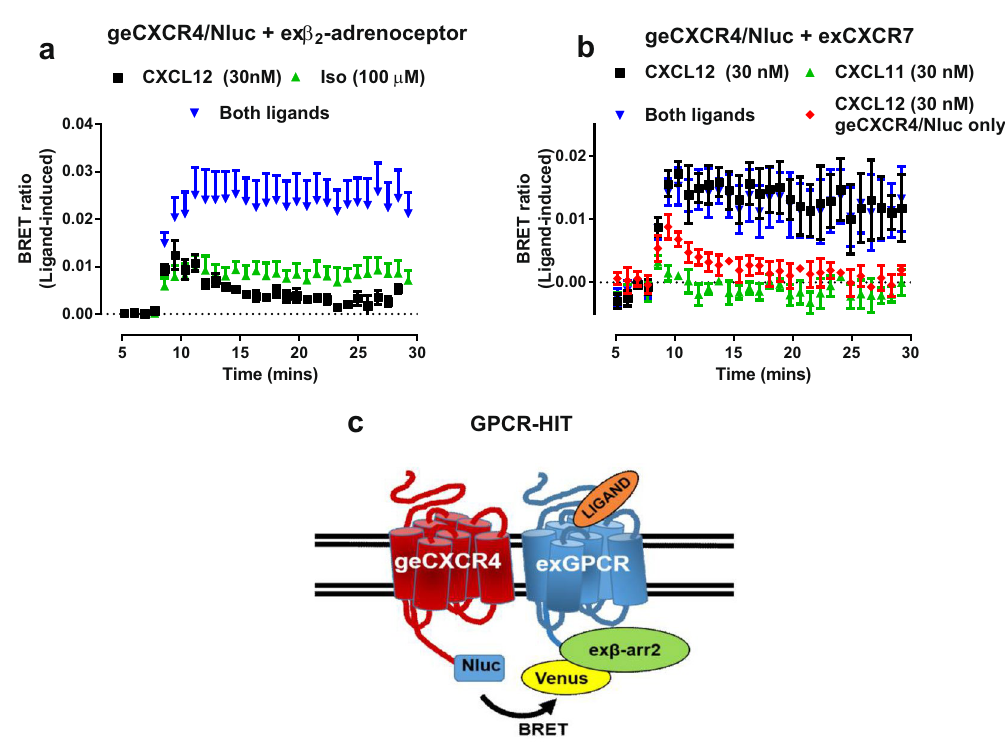
Figure 5. Demonstration of GPCR-HIT BRET assay using genome-edited CXCR4. HEK293FT cells expressing genome-edited CXCR4 fused to Nluc (geCXCR4/Nluc) transiently transfected with cDNA coding for β -arrestin2/Venus and ( a ) β 2 -adrenoceptors or ( b ) CXCR7 were used to carry out BRET assays using the GPCR-HIT configuration. ( a ) Cells were stimulated with CXCL12 (30 nM, black squares), isoprenaline (100 µ M, green upward triangles) or both ligands simultaneously (blue downward triangles) or ( b ) CXCL12 (30 nM, black squares), the CXCR7-specific ligand CXCL11 (30 nM, green upward triangles) or both ligands simultaneously (blue downward triangles). ( b ) For comparison, responses mediated by CXCL12 (30 nM, red diamonds) in HEK293FT cells expressing genome-edited CXCR4 fused to Nluc (geCXCR4/Nluc) transiently transfected with only cDNA coding for β -arrestin2/Venus is shown. ( c ) Schematic representation of the GPCR- HIT configuration using NanoBRET. ‘BRET ratio (ligand-induced)’ was calculated as described in Methods . Points represent mean BRET ratio ± S.E.M.; bars represent maximum corrected BRET ratio ± S.E.M. observed in kinetic time courses. Ligand added at approximately 8 minutes. Data generated from three independent